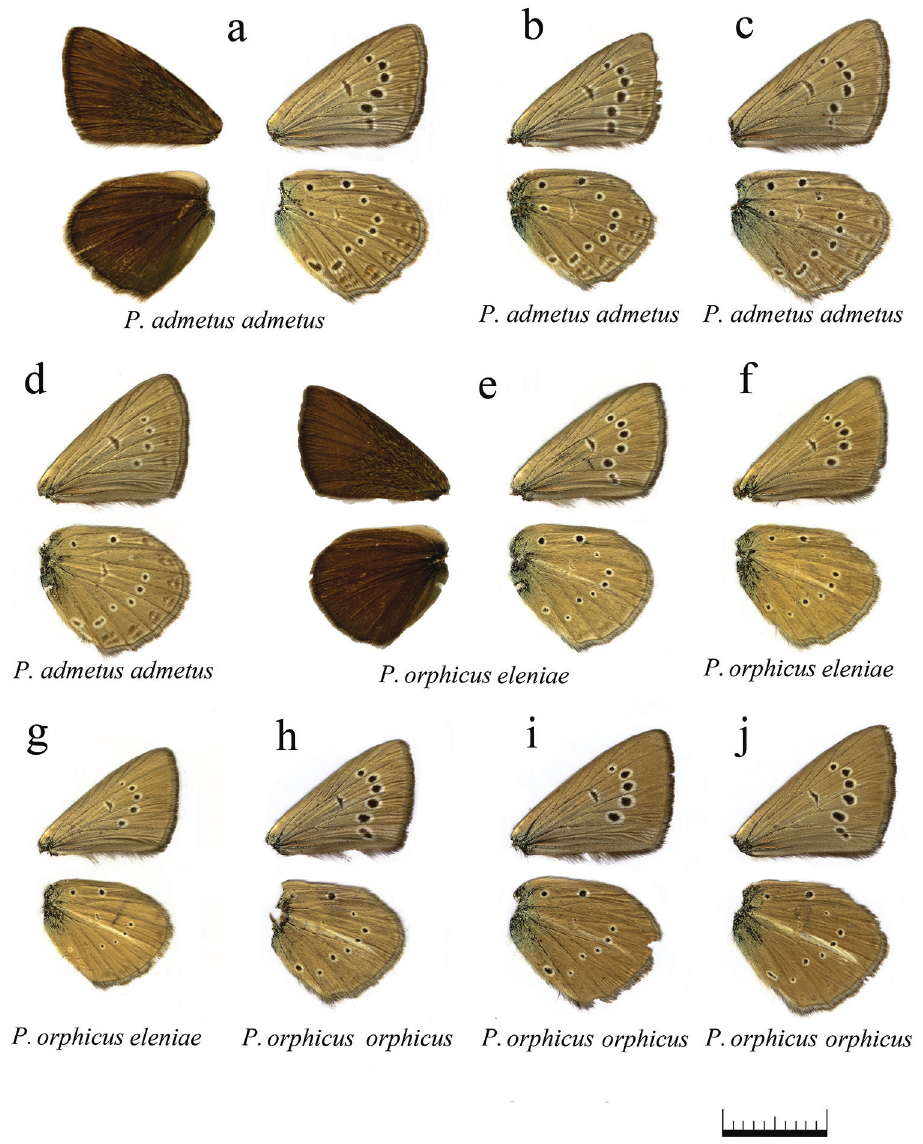
Figure 13. The coloration and wing pattern of P. admetus , P. orphicus eleniae and P. orphicus orphicus . The letters correspond to the following sample numbers: a LR-08-D109 upperside and underside b